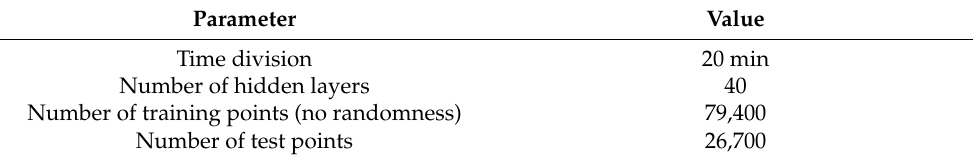
Table 13. Network configuration parameters used to evaluate the impact of added